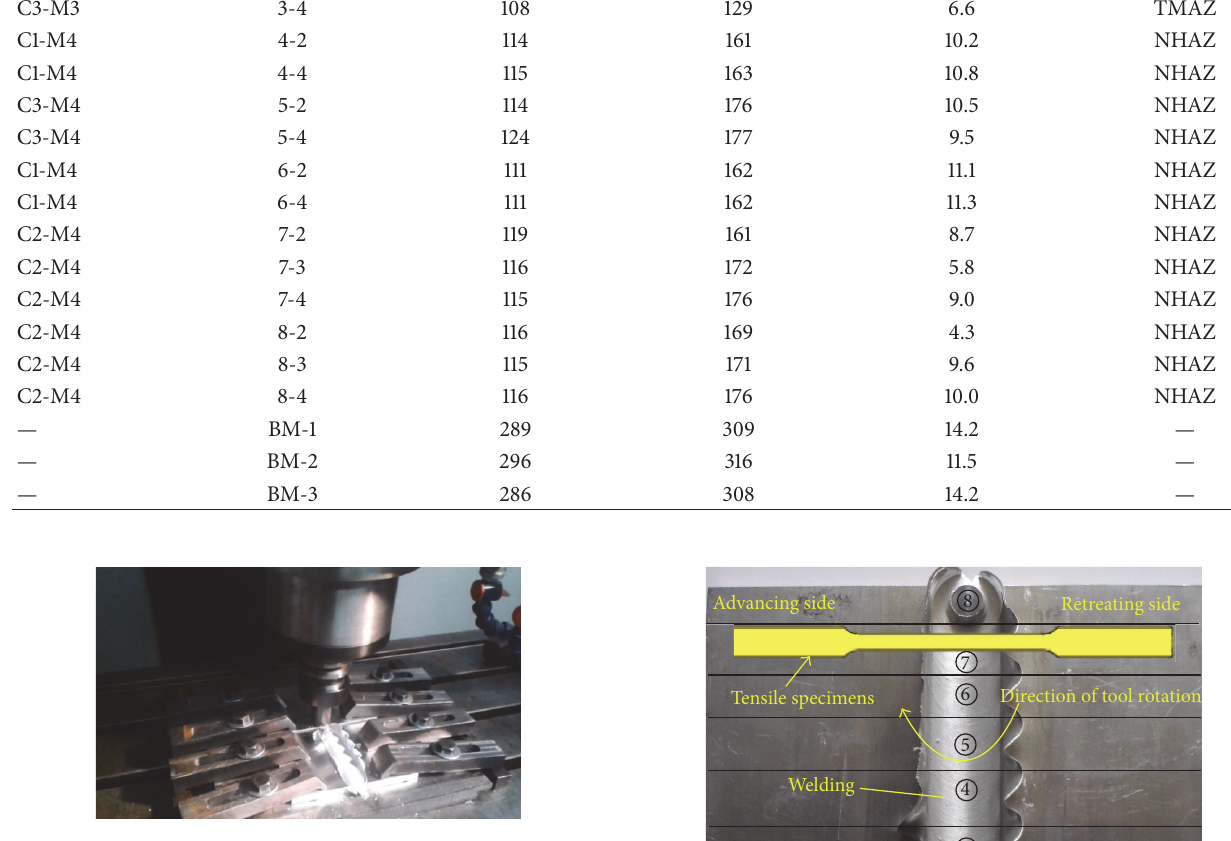
Figure 3: The two welding plates clamped to machine bed and the welding tool at the end of the FSW process.